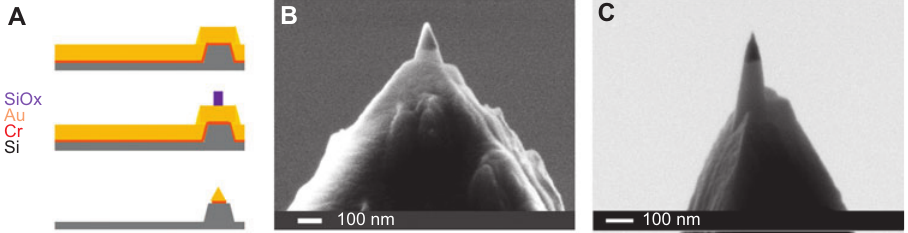
Figure 23 (A) Schematic outline of the process fl ow for the fabrication of cantilever-based gold cone scanning probes: cutting the cantilever tip by focused gallium ion beam milling, metallization of the cantilever with a thin Cr or Ti adhesion layer and a gold layer, the thickness of which corresponds to the envisaged cone height, creating a local etch mask on the plateau by EBID, and removing the etch mask and residual N contact mode cantilever pyramid, sidewall roughness inherent to as-bought gold by argon ion milling. (B) Gold cone scanning probe on a Si 3 4 cantilevers. (C) Gold cone probe on self-aligned Si pillar on Si noncontact mode cantilever tip. Cone heights are on the order of 100 nm. Images by M. Fleischer, probes fabricated at The Molecular Foundry. Figure 23B adapted with permission from [153] . Copyright 2011, American Chemical